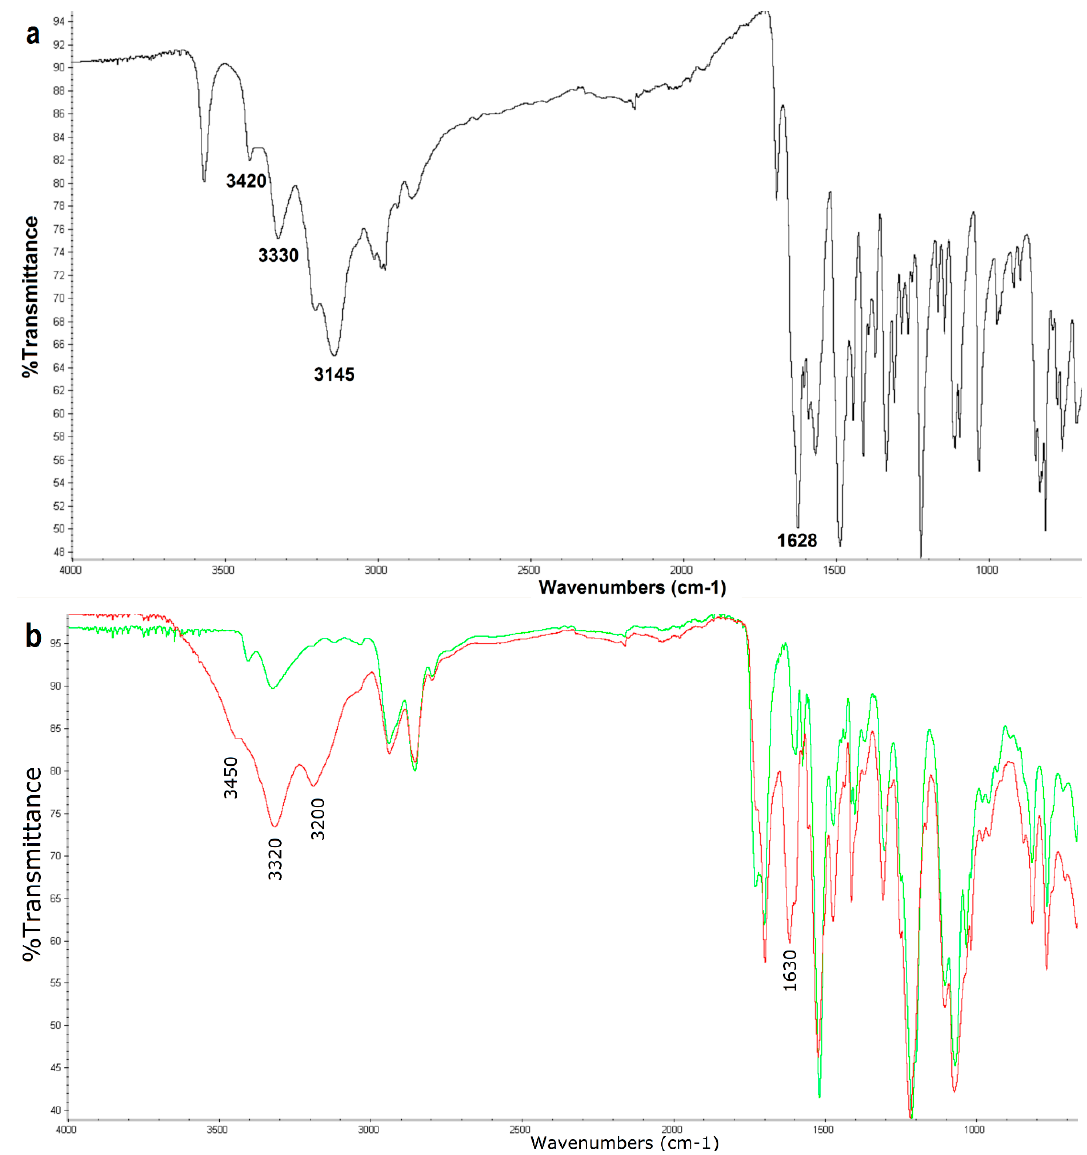
Figure 6. FTIR spectrum of ethacridine lactate ( a ); FTIR spectra of the bromine-treated catheter (green line) and the ethacridine-treated catheter (red line) ( b ).